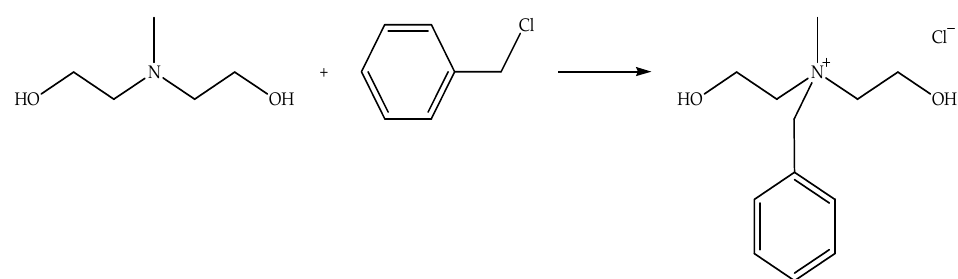
Figure 1. Schematic of the quaternization of N -methyldiethanolamine with benzyl chloride to produce benzylbis(2-hydroxyethyl)methylammonium chloride.